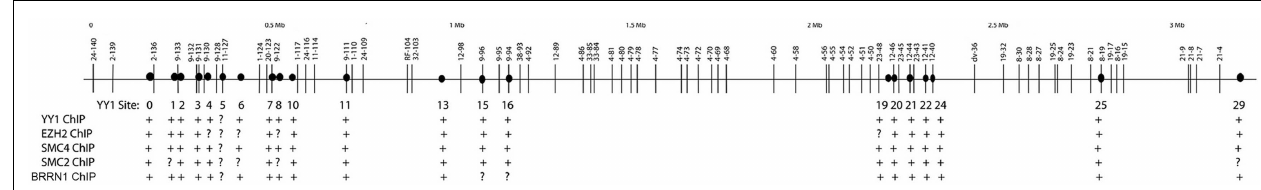
Summary of ChIP data forYY1, EZH2, SMC4, SMC2, and BRRN1 are shown in the bottom panel. Positive ChIP signals are represented by a + symbol and question marks show inconclusive ChIP